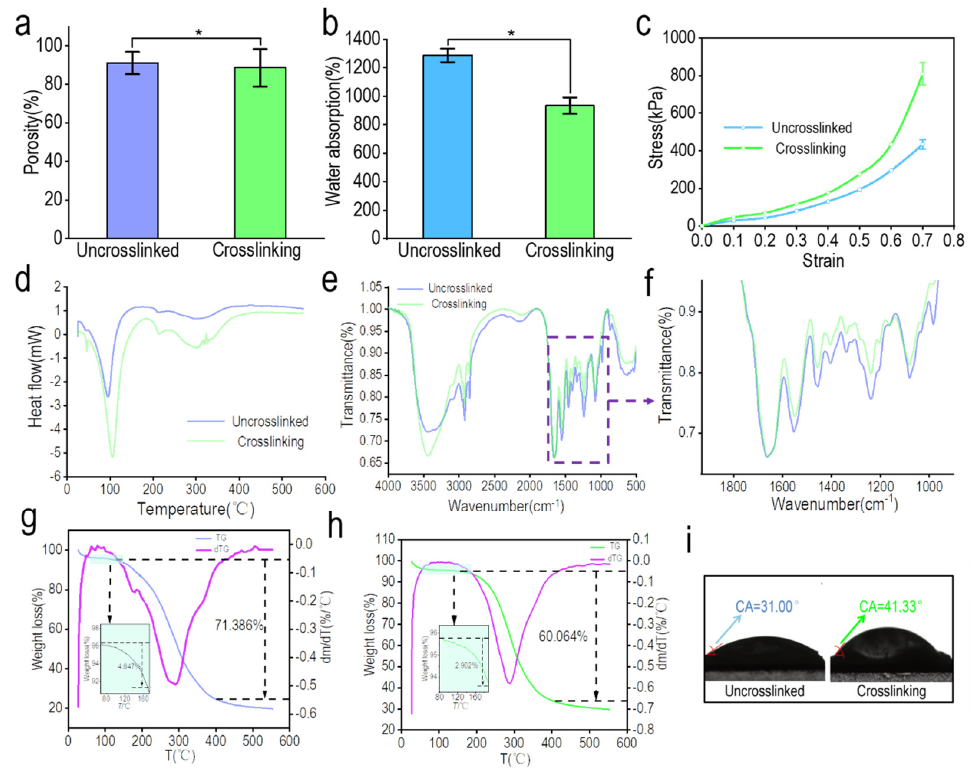
Figure 3. Physical performance analysis of pig nephritic-derived matrix scaffolds before and after crosslinking. ( a ) Porosity test of pig kidney matrix scaffolds before and after crosslinking, * p < 0.05. ( b ) Water absorption test of pig kidney matrix scaffolds before and after crosslinking, * p < 0.05. ( c ) Compression modulus test of pig kidney matrix scaffold before and after crosslinking. ( d ) Dif- ferential calorimetry scanning test of pig kidney matrix scaffolds before and after crosslinking. ( e ) Infrared spectrum detection of pig kidney matrix scaffolds before and after crosslinking. ( f ) Am- plification of infrared spectrum at 1000~1800 cm − 1 . ( g ) TG analysis and TG differential curve of uncrosslinked pig renal matrix scaffolds. ( h ) TG analysis and TG differential curve of pig kidney matrix scaffolds after crosslinking. ( i ) Test of the contact angle of the pig kidney matrix scaffolds before and after